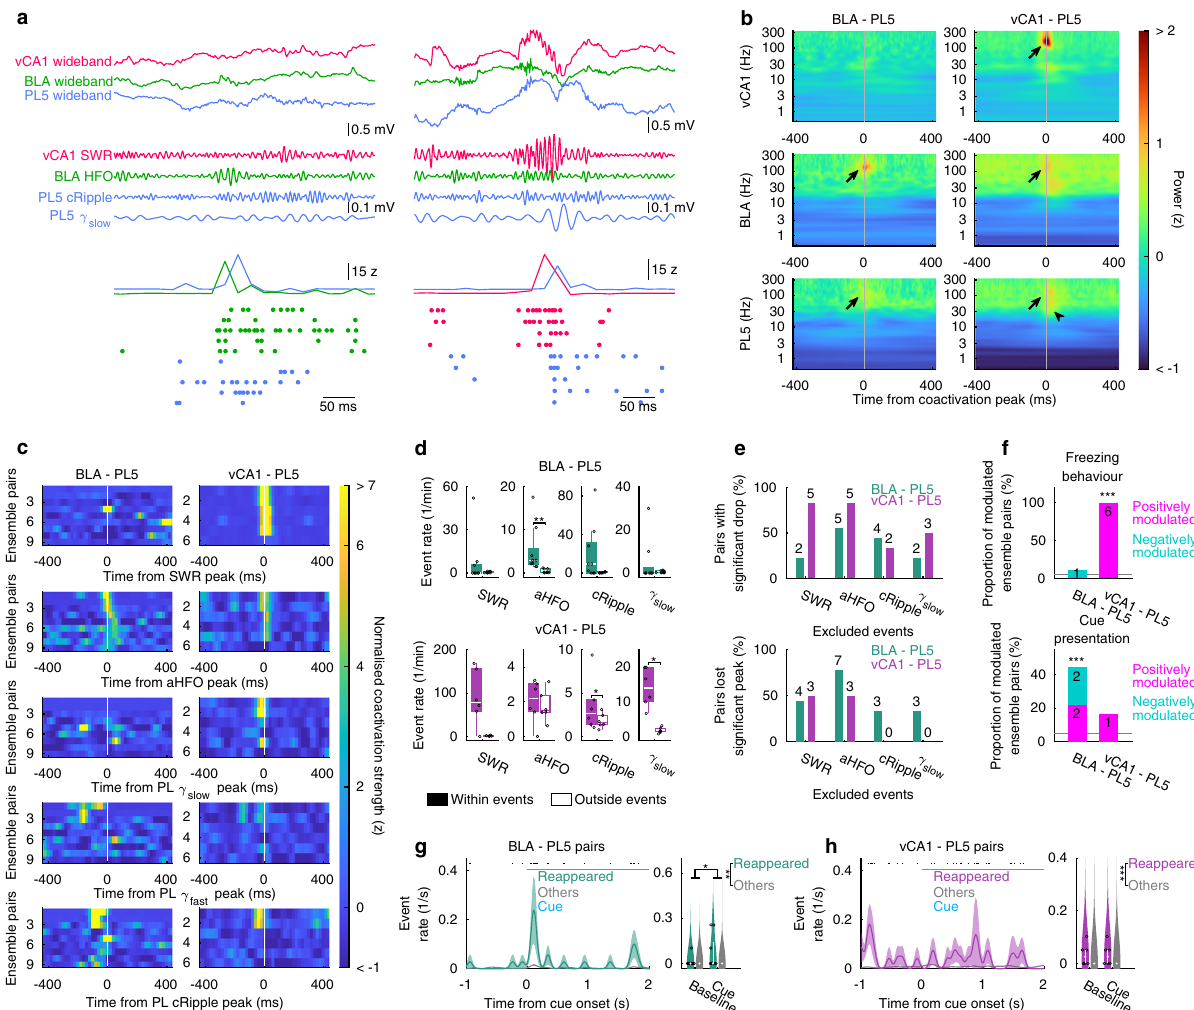
Fig. 8 Fast oscillations host coactivation during memory retrieval. a Representative examples of BLA – PL5 (left) and vCA1 – PL5 (right) coactivation, as in Fig. 4a, but during cue-retention/extinction sessions. b , c Coactivation-triggered average of LFP wavelet power ( b ), and oscillatory event-triggered average of instantaneous coactivation strength ( c ) during cue-retention/extinction sessions. Only reappeared-ensemble-pairs were used. The black arrows and arrowhead in ( b ) indicate the peaks re fl ecting SWRs/aHFOs/cRipples in vCA1/BLA/PL5 and γ slow in PL5, respectively. In panel ( c ), the BLA – PL5 and vCA1 – PL5 ensemble pairs were sorted based on the height of HFO- and SWR- triggered average peaks around time 0, respectively. d Box plots indicate coactivation event rates of reappeared-ensemble-pairs within/outside oscillatory events during cue-retention/extinction sessions. The centre lines and limits of the boxes represent median and quartiles, respectively, and whiskers extend to the maxima and minima with outliers excluded. Open circles indicate individual data points, including outliers, with random horizontal jitters for visualisation. *** p < 0.001, ** p < 0.01, * p < 0.05, WSR-test. e Proportions of reappeared-ensemble-pairs that signi fi cantly ( p < 0.01, tested using random jittering analysis; see “ Methods ” ) reduced CCG peak height and that lost signi fi cant peaks on CCG by excluding time bins containing SWRs, aHFOs, cRipples, or γ slow . f Proportion of reappeared-ensemble-pairs for which coactivation event rates indicated signi fi cant positive or negative modulation by freezing behaviour (top) or cue presentation (bottom). Horizontal bars indicate the chance level (5%). *** p < 0.001, χ 2 test. g , h Cue-onset-triggered averages of the coactivation event rates in BLA – PL5 ( g ) and vCA1 – PL5 ( h ) ensemble pairs. In the left panels, the line and shaded area indicate the mean and SEM, respectively. Periods in which the event rates of reappeared- ensemble-pairs were signi fi cantly different from those of other ensemble pairs are indicated with black ticks on the top ( p < 0.05, WSR-test). Right panels are violin plots showing event rates in periods 0.05 – 0.55 s prior to/following cue onsets (baseline and cue, respectively). White dots and lines represent medians and quartiles, respectively. Individual data points of reappeared-ensemble-pairs are shown with open circles with horizontal random jitters for visualisation. *** p < 0.001, ** p < 0.01, * p < 0.05, post hoc TK test following two-way ANOVA on the ranks. For ( b – h ), data obtained from the entire cue- retention/extinction session were used, and the numbers of analysed ensemble pairs are summarised in Supplementary Table 6. In ( e ) and ( f ), the numbers of pairs are superimposed on the top of the bars. Detailed statistics are shown in Supplementary Data 1. Source data are provided as a Source Data fi